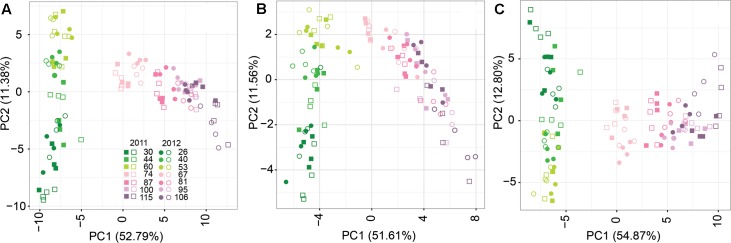
Principal component analysis (PCA) of CT (full symbols) and WD (open symbols) berry metabolite profiles in 2011 (squares) and 2012 (dots). (A) Whole set of metabolites; (B) Central metabolites; (C) Specialized metabolites. Colors from dark green to light pink to violet refer to developmental stages (DAA) of the berry as reported in the figure legend.